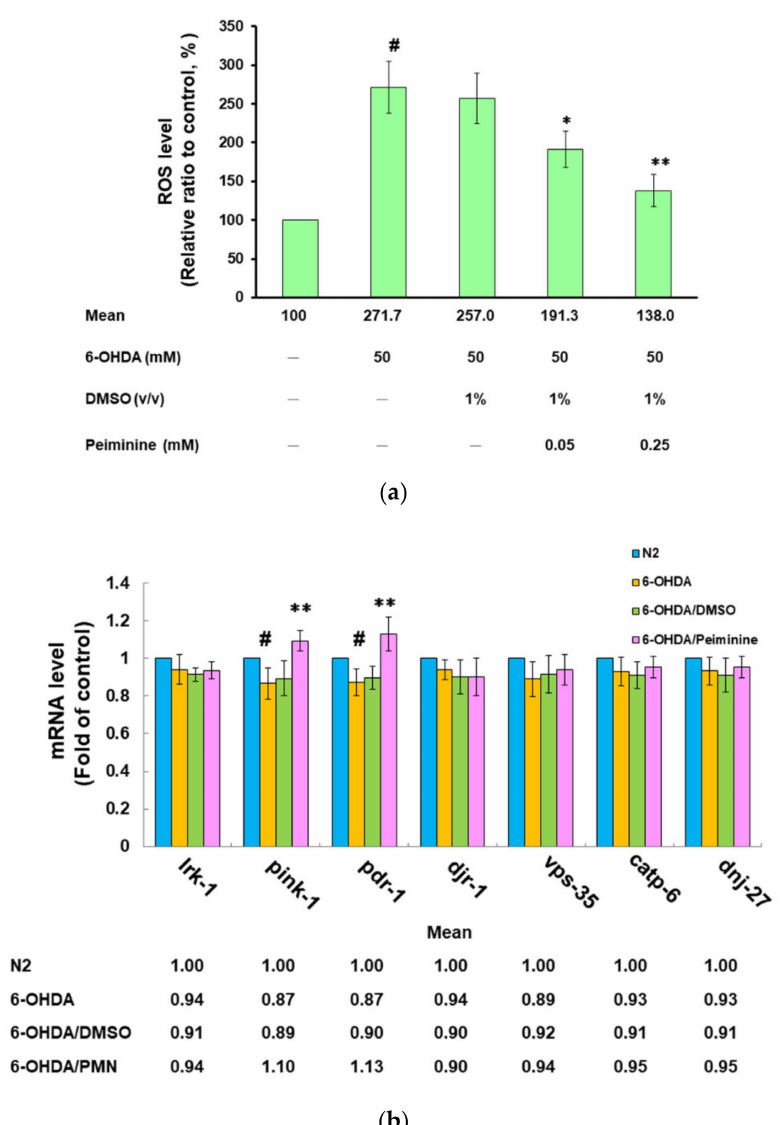
Figure 5. Pretreatment with peiminine (PMN) significantly lessened the level of reactive oxygen species (ROS) in 6-hydroxydopamine (6-OHDA)-exposed N2 worms and augmented the expression of pink1 and pdr-1 . L1 stage N2 worms were transferred to OP50/NGM plates with or without PMN and grown to the L3 stage, exposed to 6-OHDA for 1 h, and then transferred to OP50/NGM/FUDR plates with or without PMN and cultured for another 3 days for analysis. ( a ) Thirty worms randomly selected from each group were transferred to the wells of a 96-well plate, and the 2 (cid:48) ,7 (cid:48) -dichlorodihydrofluorescein diacetate (H2DCFDA) probe was used to detect the level of intracellular ROS. # Indicates a significant difference between the 6-OHDA-exposed group and the control group ( # p < 0.001); * Indicates a significant difference between the PMN- pretreated 6-OHDA-exposed group and the PMN-untreated 6-OHDA-exposed group (* p < 0.05, ** p < 0.01). ( b ) qPCR was used to quantify the mRNA levels of PD-related homologous genes in worms. # Indicates